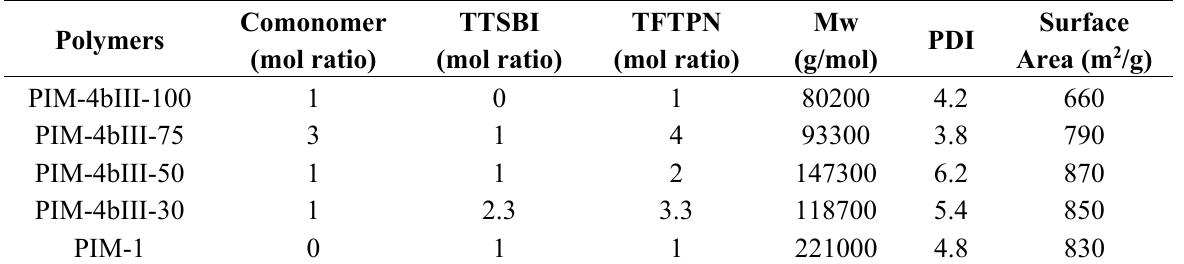
Table 1. Physical properties of homopolymers, copolymers and PIM-1.